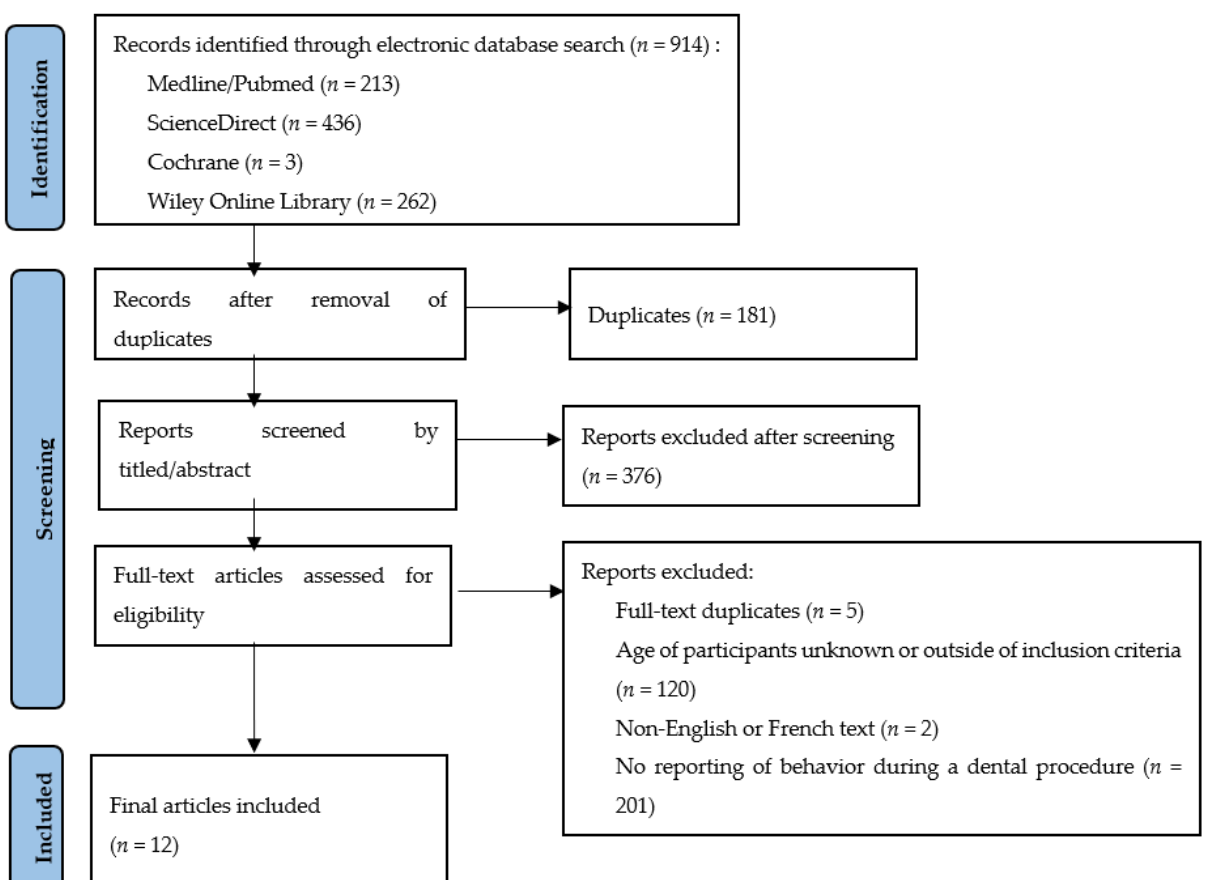
Figure 1. Flow chart of selected Figure 1. : Flow chart of selected articles.